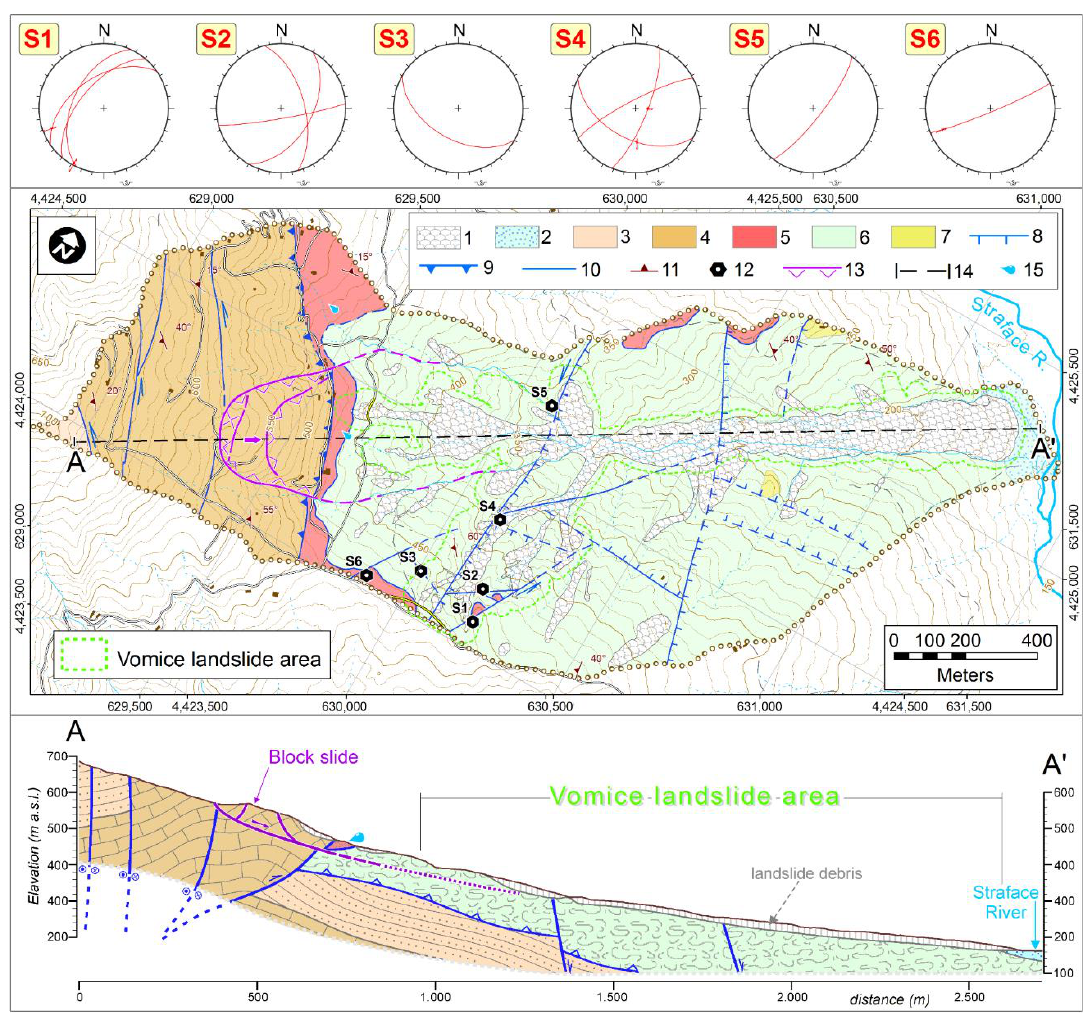
Figure 2. Geostructural map of the study catchment with localization of mesostructural stations and synthesis of mesostructural data and a geological cross section of the slope. Legend: (1) Holocene landslide debris; (2) Holocene alluvial deposits; (3) Albidona Formation (Burdigalian); (4) Saraceno Formation (Upper Oligocene-Aquitanian); (5) Numidian Flysch (Lower Miocene); (6) Lower varicolored clays (Cretaceous); (7) olistoliths of the Sant’Arcangelo Formation (Upper Cretaceous-Middle Eocene); (8) normal fault; (9) thrust; (10) tectonic contact; (11) attitude of strata; (12) mesostructural station; (13) deep-seated rock-slide; (14) geological cross-section; (15) spring.